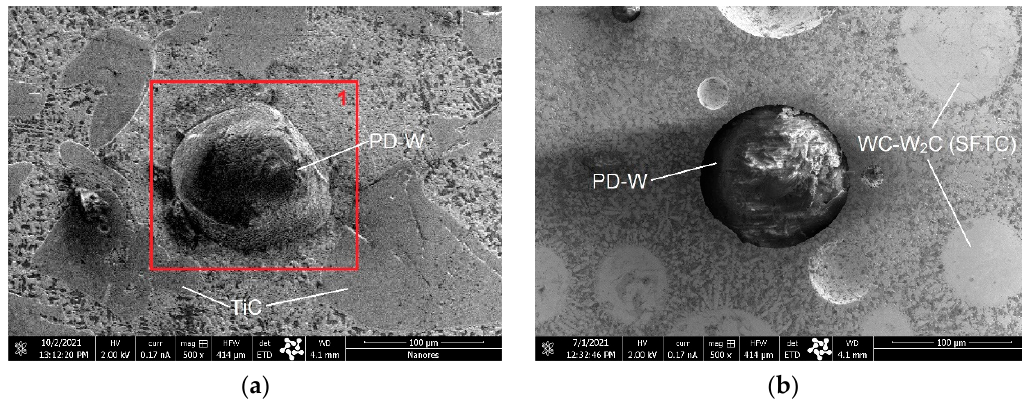
Figure 7. SEM image of the structure of selected composite layers padded using the PPTAW method with a powder on an alloy matrix: ( a ) cobalt with a hard reinforcing phase in the form of particles of crushed TiC and spherical polycrystalline synthetic diamond (C1 filler material); ( b ) nickel with a hard reinforcing phase in the form of particles of WC-W 2 C spherical and broken tungsten carbide and PD-W spherical polycrystalline synthetic diamond (C3 filler material).